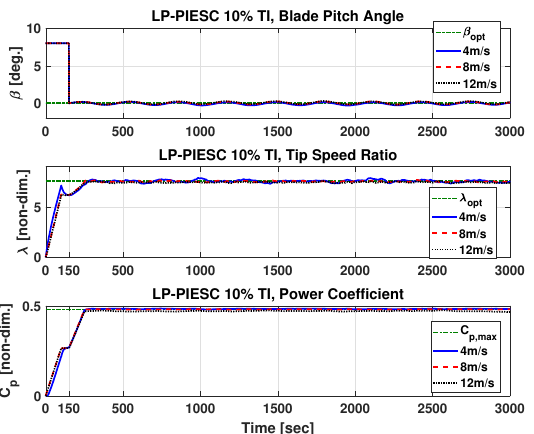
Figure 25. Performance of LP-PIESC with the parameters shown in Table 6 and hub-height wind from Figure 6. Blade pitch angle β ( top ), tip speed ratio λ ( middle ), and estimated power coefficient C p ( bottom ). The dashed horizontal lines indicate optimal parameters β opt , λ opt and C P ,max . The LP- PIESC is turned on at 150